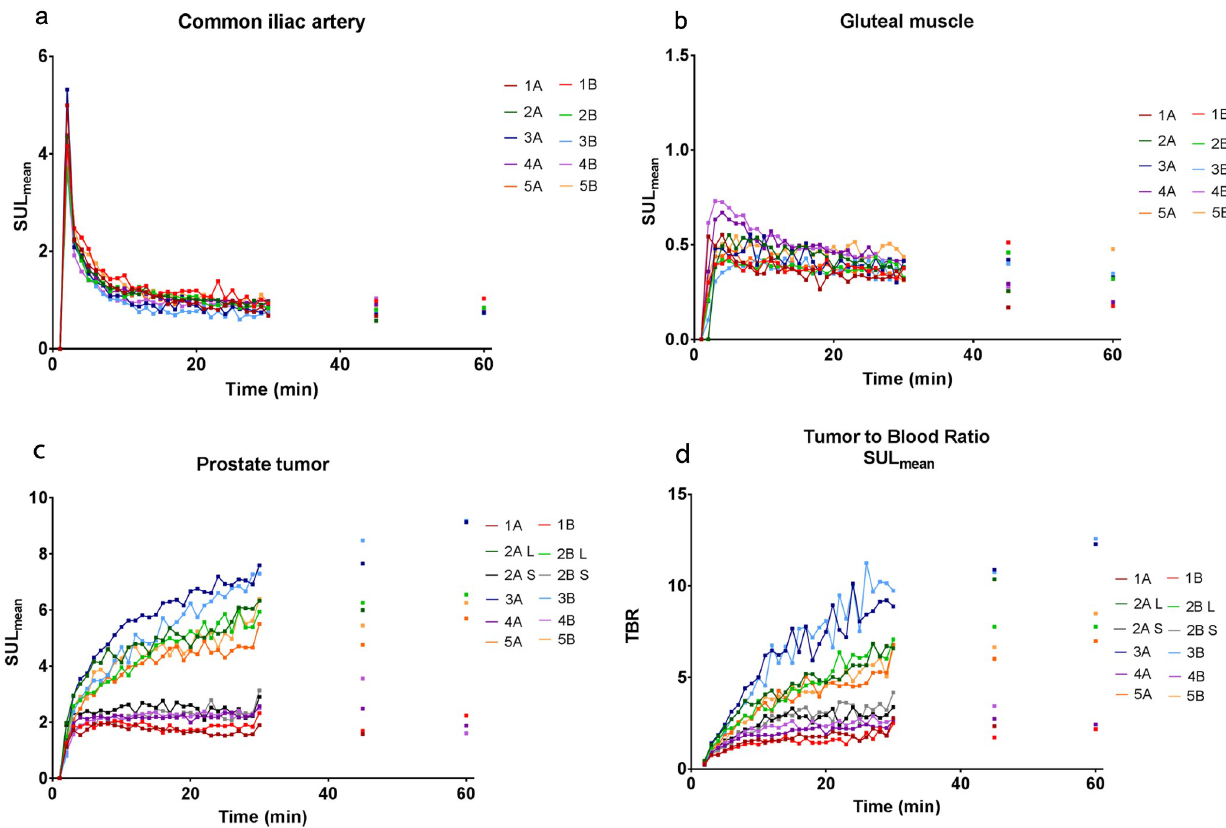
Fig 2. The SUL mean time activity curve of all patients for the common iliac artery (A), gluteal muscle (B), prostate tumor (C), and the TBR (D). The TAC of the prostate tumor shows clear deviation in patients 1. 2S,4 which become stable in uptake after 5 minutes and the 2L,3,5 which keep increasing. Note that patient 2 has a large (L) and a small (S) lesion.